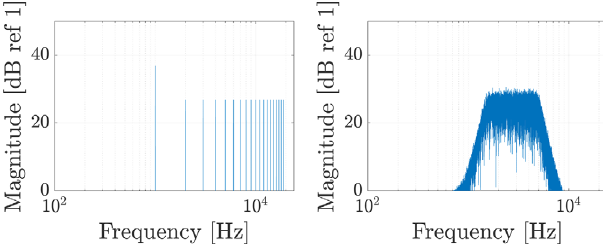
Figure 3. Frequency spectrum of the tonal (left) and broad- band (right) reversing alarms. Both alarm signals include frequency components in the 500 Hz to 2500 Hz frequency range, as required by ISO 7731:2003